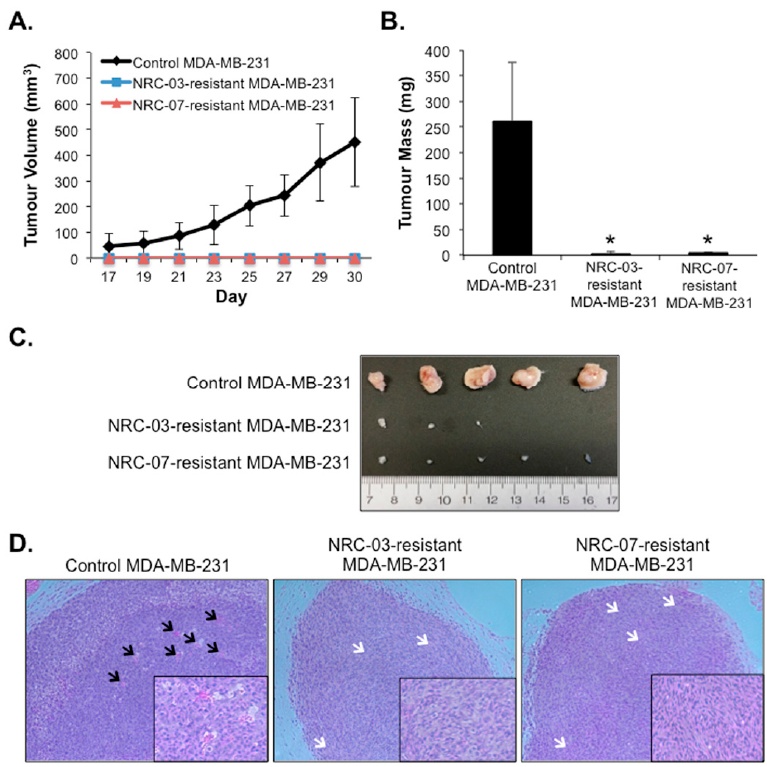
Figure 5. NRC-03-resistant and NRC-07-resistant breast cancer cells exhibit impaired tumorigenicity, tumor growth and tumor-associated angiogenesis. Parental MDA-MB-231 cells, NRC-03-resistant MDA-MB-231 cells, or NRC-07-resistant MDA-MB-231 cells were implanted by subcutaneous injection of 5 × 10 6 cells into the hind flank of NSG mice. ( A ) Tumor volume was recorded by caliper measurements every other day until the first mouse reached its humane endpoint, at which time the mice were euthanized, and excised tumors were ( B ) weighed, and ( C ) photographed. ( D ) Tumors were fixed, sectioned and stained with hematoxylin and eosin. Images shown are from representative mice and were captured at 10× and 20× (inset) magnification. Black and white arrows indicate blood vessels and striated tumor tissue, respectively. Data shown in panel A and panel B represent the average of 5 mice ± SD and are significant (* p < 0.0001) by the Bonferroni multiple comparisons test. Note that NRC-03-resistant and NRC-07-resistant tumors were palpable on day 19, but could not be accurately measured; hence, statistical analyses were not performed on data depicted in panel A.